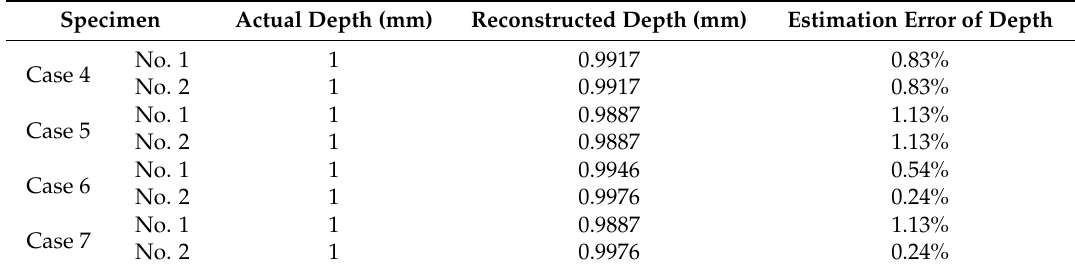
Table 4. The depth evaluations of Case 4 to Case 7.